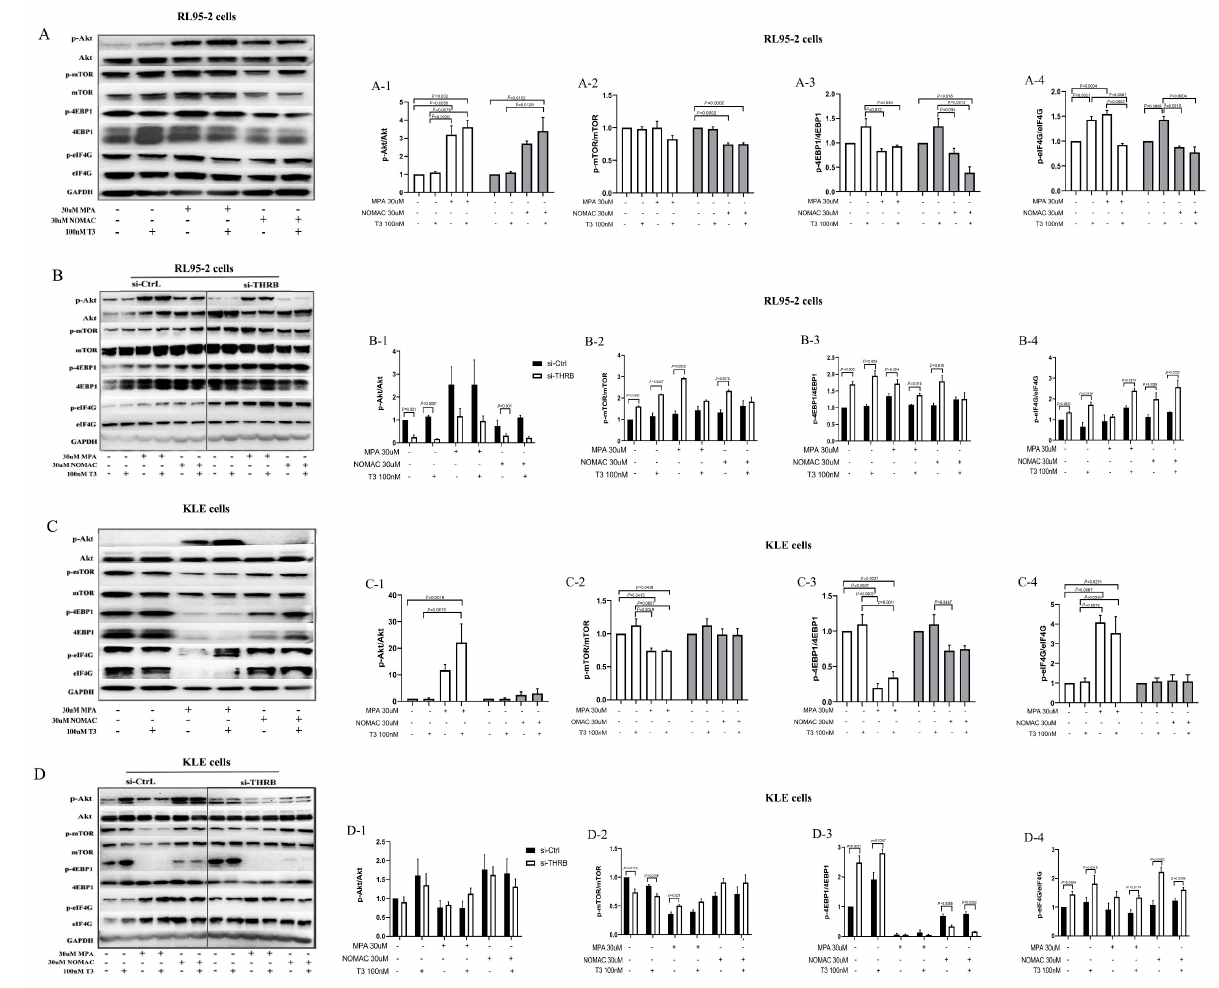
Figure 6. Effects of MPA and NOMAc on protein levels of Akt/ mTOR/ 4EBP1/eIF4G in EC cells. ( A-1,A-2,A-3,A-4 ) The expression levels of p-Akt/Akt, p-mTOR/mTOR, p-4EBP1/4EBP1 and p-eIF4G/eIF4G in wild-type RL95-2 cells. ( B-1,B-2,B-3,B-4 ) The expression levels of p-Akt/Akt, p-mTOR/mTOR, p-4EBP1/4EBP1 and p-eIF4G/eIF4G in THRB-silenced RL95-2 cells. ( C-1,C-2,C-3,C-4 ) The expression levels of p-Akt/Akt, p-mTOR/mTOR, p-4EBP1/4EBP1 and p-eIF4G/eIF4G in wild- type KLE cells. ( D-1,D-2,D-3,D-4 ) The expression levels of p-Akt/Akt, p-mTOR/mTOR, p- 4EBP1/4EBP1 and p-eIF4G/eIF4G in THRB-silenced KLE cells. The results are presented as mean ± SEM from three independent experiments. THRB, thyroid hormone receptor beta; si-Ctrl, negative control without THRB silencing; si-THRB, THRB silencing; T3, triiodothyronine; MPA, medroxy- progesterone acetate; NOMAc, nomegestrol acetate; Akt, phosphorylated protein kinase B; mTOR,